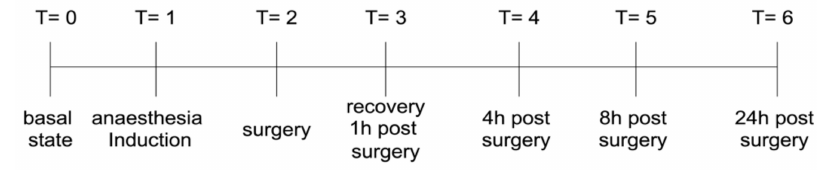
Figure 1. Experimental